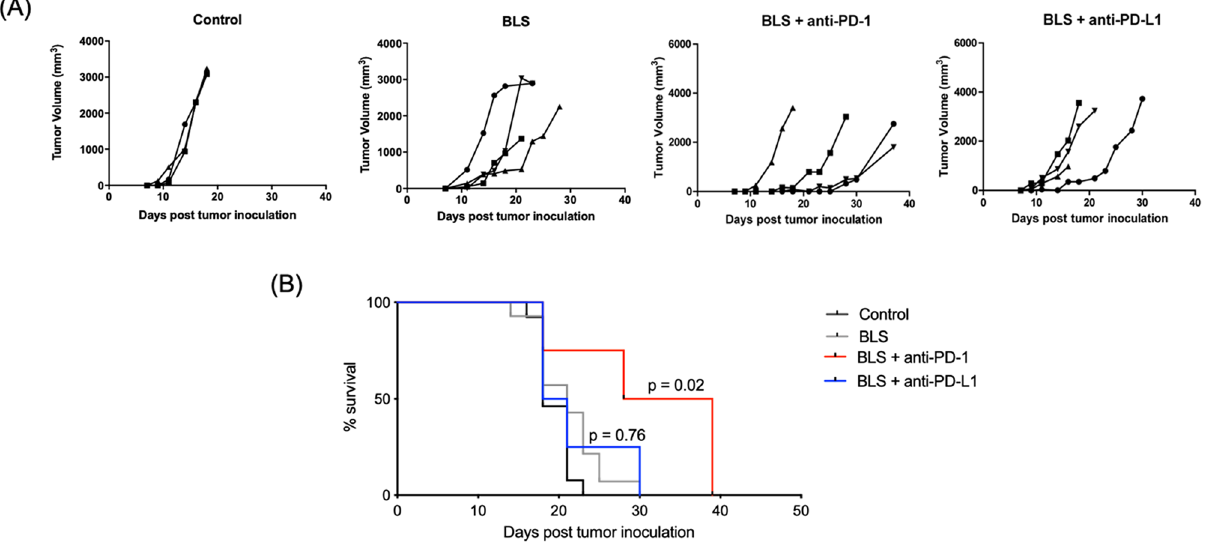
Figure 6. Combination treatment of BLS and PD-1/PD-L1 pathway blockade improves the outcome of BLS monotherapy. B16 cells were inoculated in C57BL/6J mice. At day 2, 200 μg of BLS were administered s.c., and at days 5, 8 and 11 200 µg of anti-PD-1 or anti-PD-L1 were i.p. inoculated. Tumor growth ( A ) and mice survival ( B ) were followed every 2–3 days and tumor volume was estimated as 0.5 × (length × width 2 ). Results from one representative experiment (n = 4) are